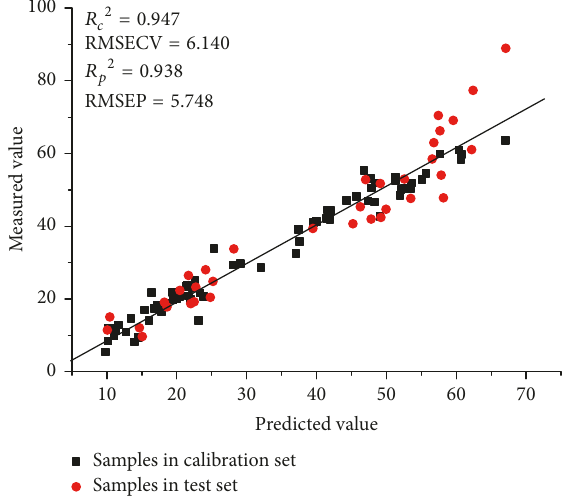
Figure 7: The analytical result of determination of gentiopicroside. (Description: the relationship between the predicted and measured concentrations of gentiopicroside is presented in this figure, based on PLSR technique.)